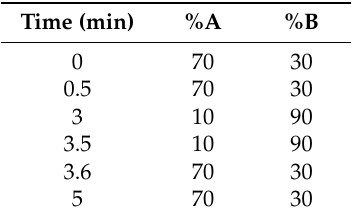
Table 2. Gradient system of mobile phases.